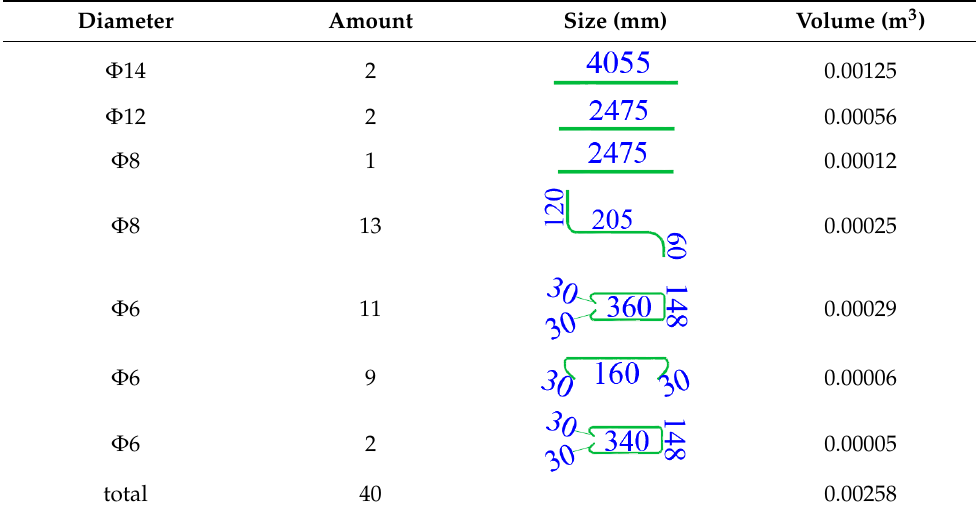
Table 2. Reinforcement characteristics of CG-2 composite beam.